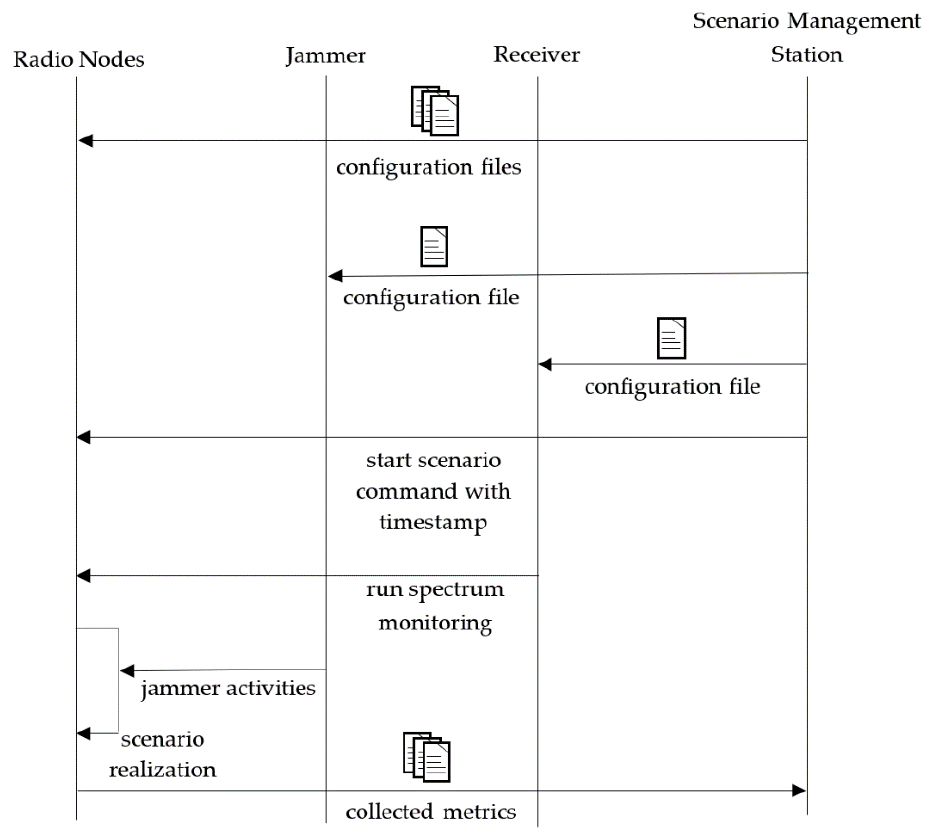
Figure 13. Sequence diagram of scenario realization.